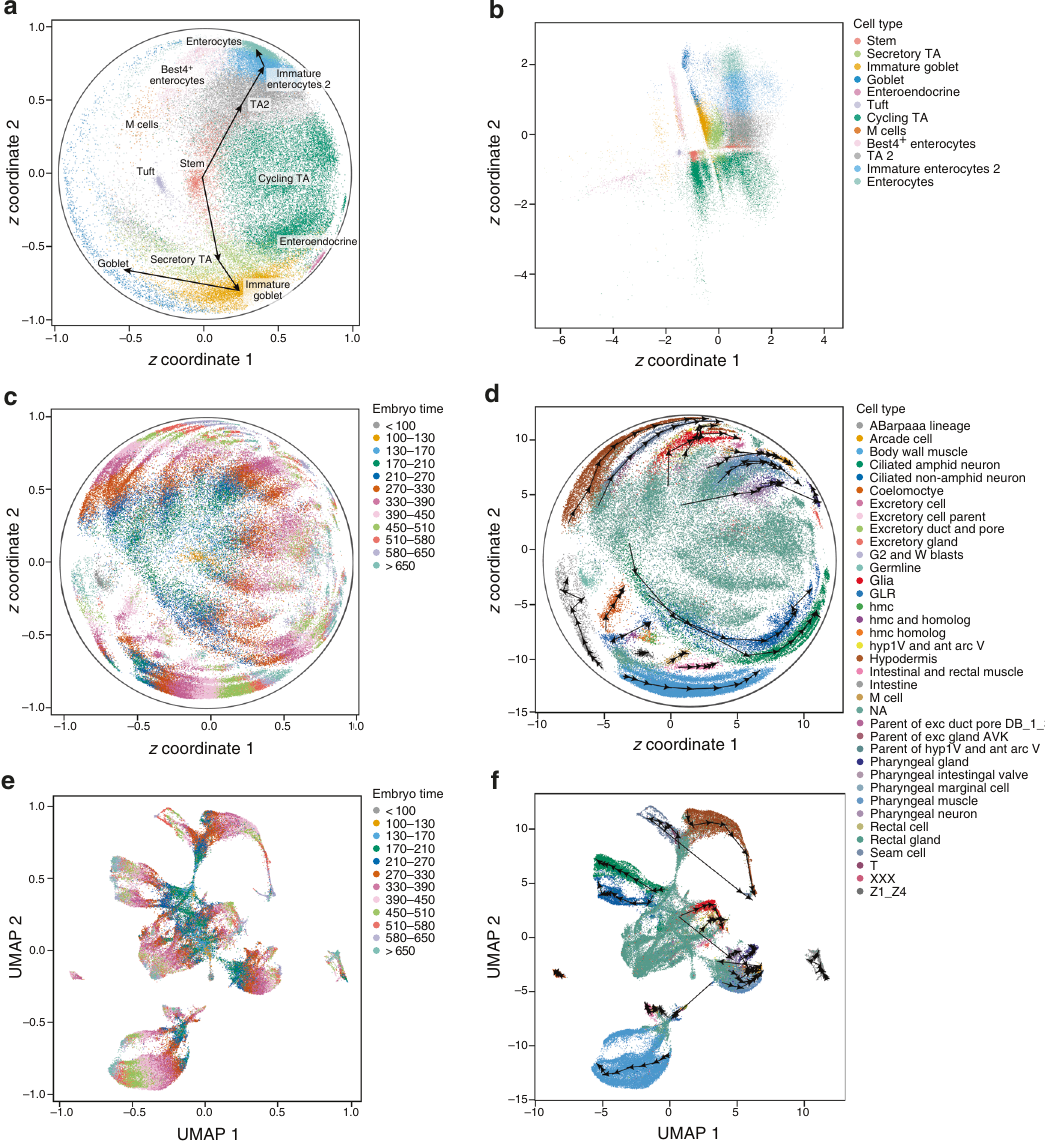
Fig. 6 Embedding cells in the hyperbolic space for trajectory discovery and interpretation. a , b Major development trajectories of colon epithelial cells are discerned from embeddings in the Poincaré disk. Single-epithelial cell pro fi les (dots) annotated by type as embedded in a Poincaré disk ( a ) or the Euclidean space ( b ). Arrows point to the next cell type in the development trajectory. c – f Embedding of cells from a C. elegans embryonic time course highlights developmental timing and differentiation to subsets. Single-cell pro fi les (dots) annotated by either time ( c , e ) or cell type ( d , f ) in a hyperbolic space of the Poincaré disk ( c , d ) or in a 2D UMAP (with 50 principal components, batch-corrected by Harmony) ( e , f ). Arrows connect the median coordinates of cells of a type in two consecutive time